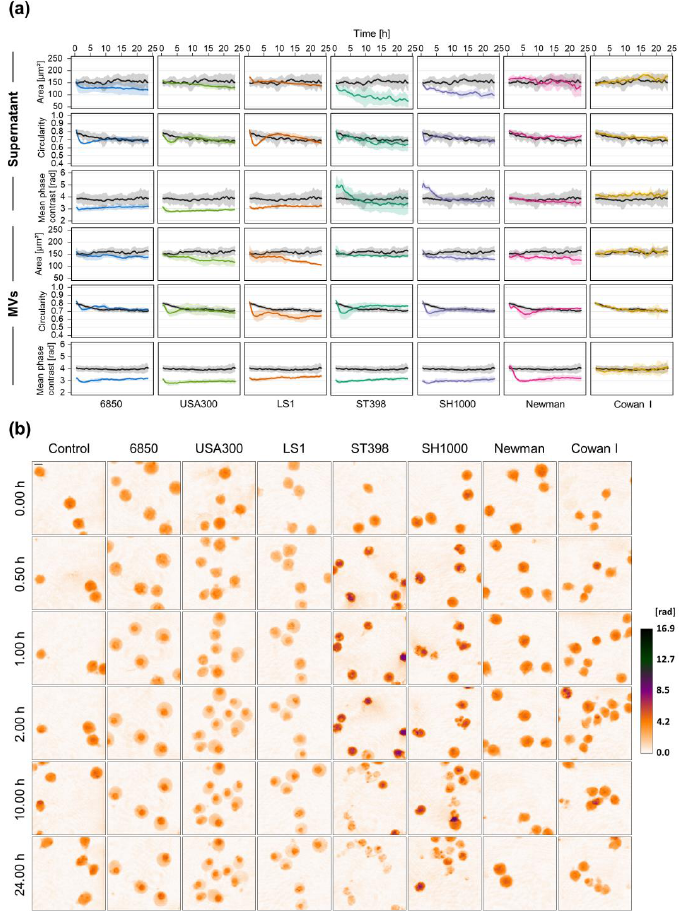
Figure 1. Cellular changes of Jurkat cells exposed to supernatant or MVs derived from different S. aureus strains. Jurkat cells were treated with 5% ( v / v ) sterile culture supernatant or 20 µg/mL MVs of different S. aureus strains. Untreated cells served as control. Cellular changes were monitored by time-lapse DHM. ( a ) DHM quantitative phase contrast images were analyzed for the average single-cell area (µm 2 ), average circularity (AU), and mean phase contrast (rad) per cell. Results are presented as mean (lines) ± SD (shading) of at least three independent experiments. Controls are depicted in black while different colors designate the individual strains. For better visualization, curves were smoothed using moving averages with a window size of 15 measuring points. ( b ) Representative color-coded phase contrast images of Jurkat cells at indicated time points after the addition of bacterial supernatant. The scale bar corresponds to 10 μm. The calibration bar indicates phase contrast values in radian.